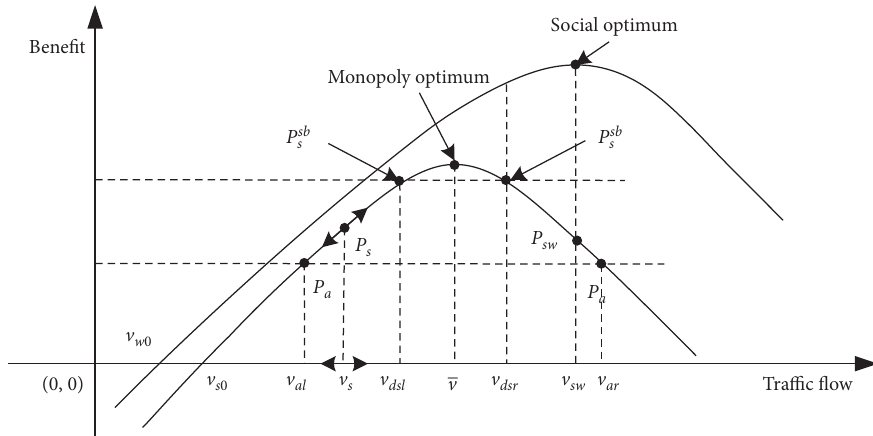
Figure 2: A geometric illustration of P